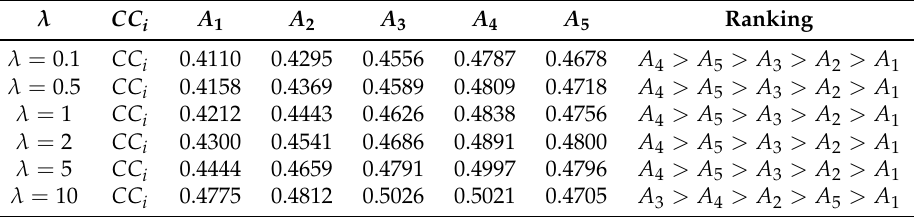
Table 7. Decision results using different λ with hesitant intuitionistic fuzzy linguistic elements